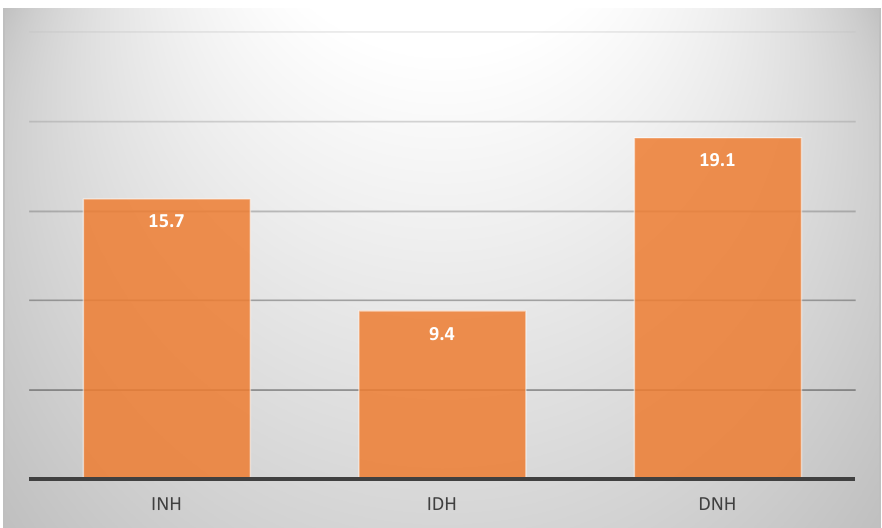
Figure 3. Prevalences of isolated nocturnal hypertension, isolated diurnal hypertension, and day- night hypertension. INH, isolated nocturnal hypertension; IDH, isolated diurnal hypertension; DNH, day-night hypertension.